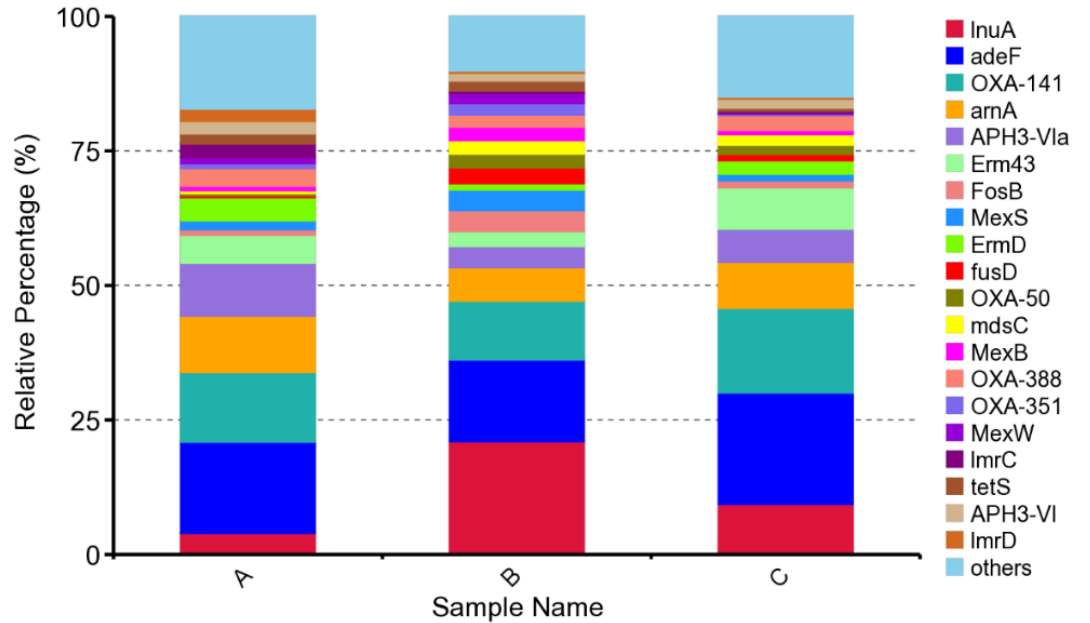
Figure 6. Composition and distribution of shared ARGs during suancai fermentation.